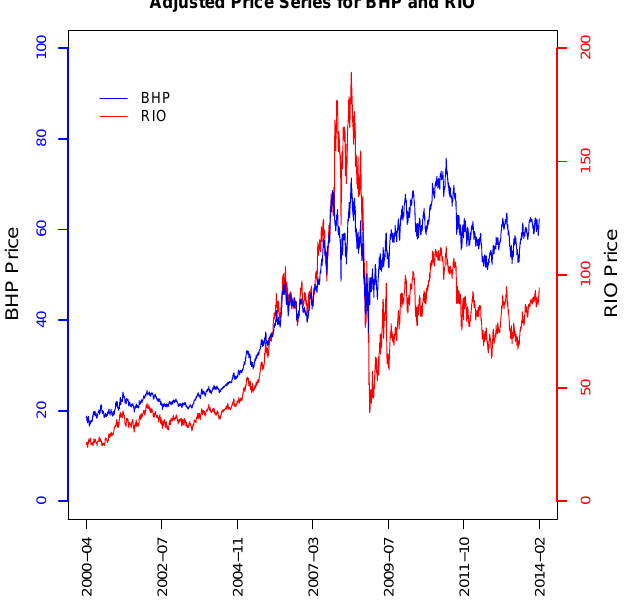
Figure 8. Time series plot of two stocks in Basic Materials identified in component 155: BHP and Rio Tinto